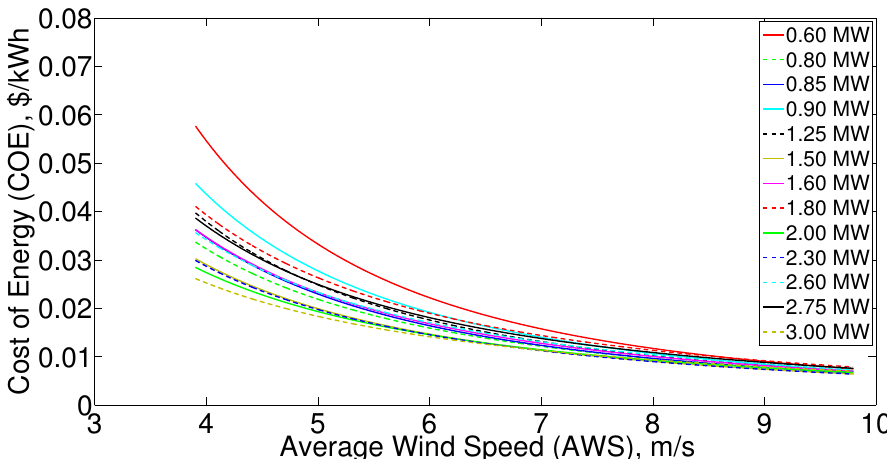
Figure 10. Variation of the minimized COE (given by the best performing turbines) with AWS: polynomial regression fits.